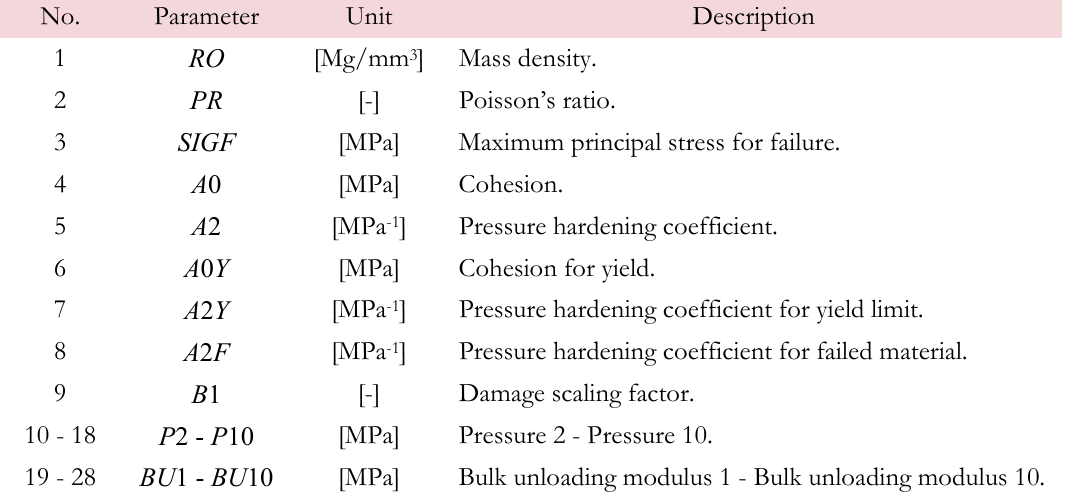
Table 1: The identified parameters of the K & C Concrete